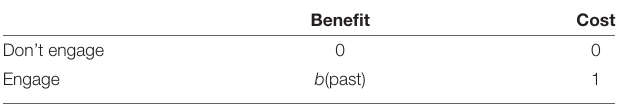
TABLE 1 | Simple framing of the PCP as a parametric decision problem.